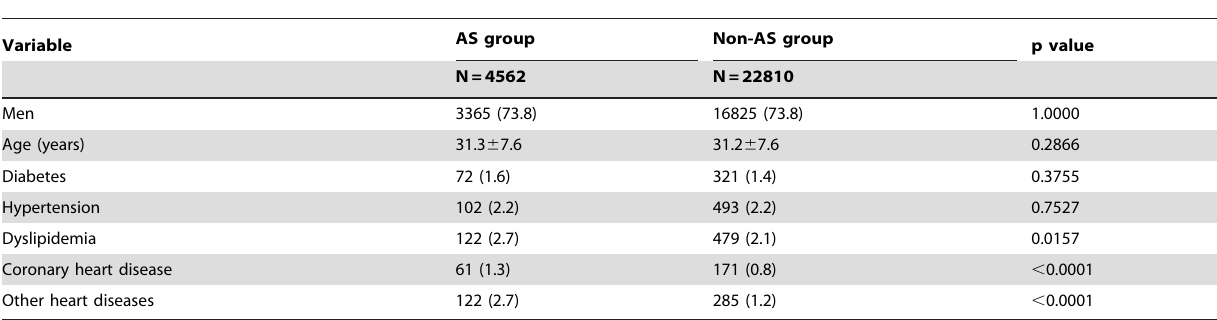
Table 1. Demographic and clinical characteristics of the AS and non-AS groups.